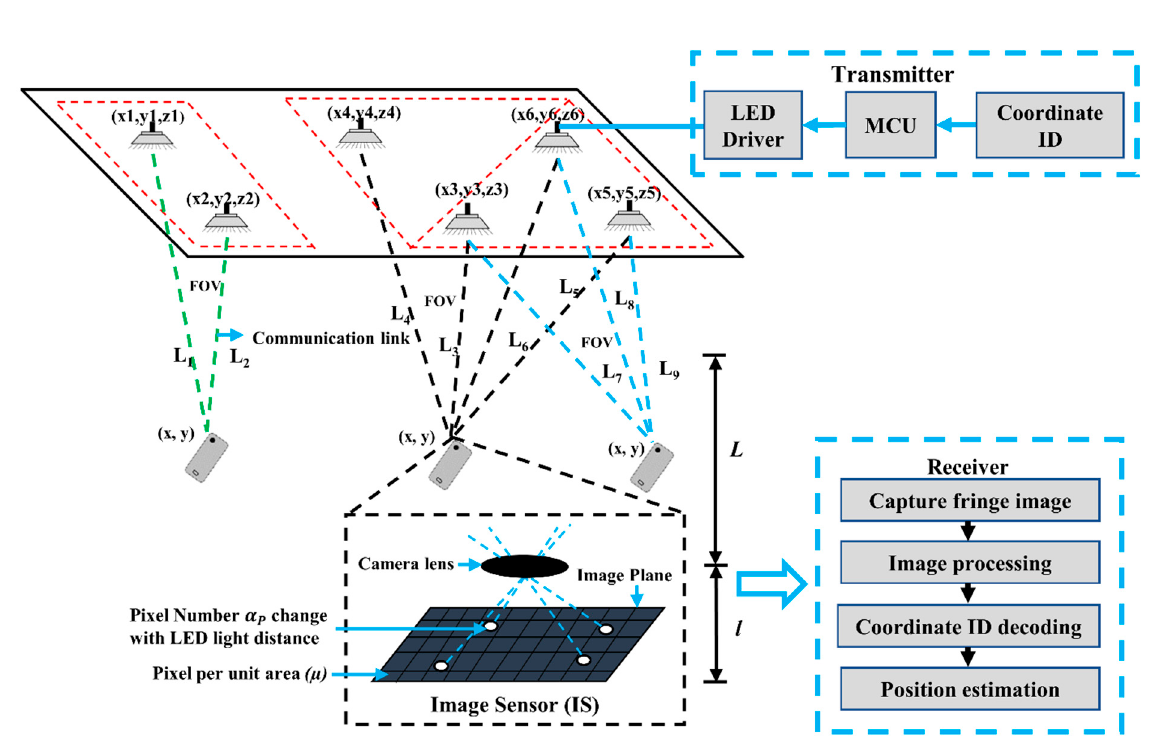
Figure 7. Positioning system infrastructure installed with ceiling LED lights as a transmitter and smartphone image sensor as a receiver.